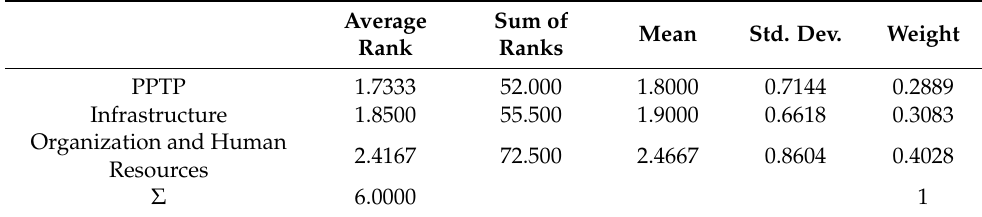
Figure 9. Readiness factor results by group. Table 7. Weighting of goals